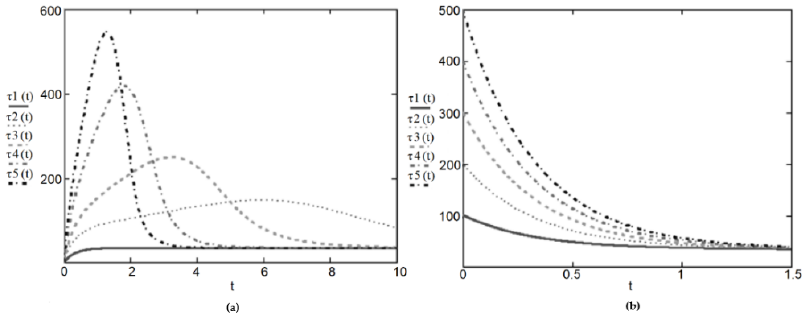
Figure 4. Creep curves γ –t at τ 1 > τ 2 > ⋯ τ 5 (the top part) and the long-term strength curve (the bottom part) τ (0) → τ ( ∞ ) at t → ∞ , obtained using Formula (3).